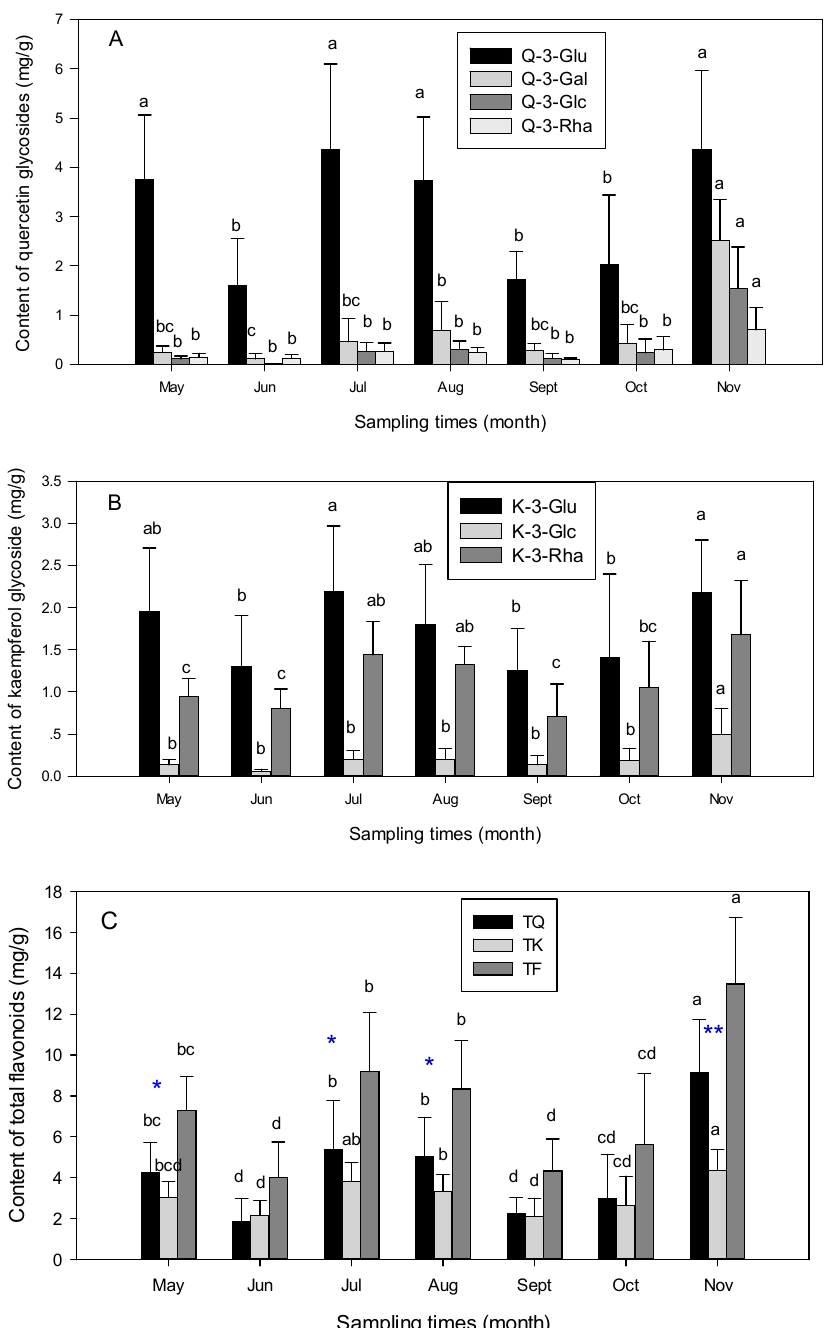
Figure 3. Seasonal variation of quercetin glycosides ( A ), kaempferol glycosides ( B ) and total flavonoids ( C ) in leaves of C. paliurus (mean ± SD). Q-3-Glu, Q-3-Gal, Q-3-Glc, Q-3-Rha, K-3-Glu, K-3-Glc, K-3-Rha, TK, TQ, and TF represent quercetin-3- O -glucuronide, quercetin-3- O -galactoside, quercetin-3- O -glucoside, quercetin-3- O -rhamnoside, kaempferol-3- O -glucuronide, kaempferol-3- O -glucoside, kaempferol-3- O -rhamnoside, total quercetin glycosides, total kaempferol glycosides, and total flavonoids, respectively. Different letters in this figure indicate significant differences between the sampling times for the same category according to Duncan’s test ( p < 0.05). Each value presented is the mean of 10 families. * and ** indicate variation between total content of quercetin glycosides and total content of kaempferol glycosides in the same month is significant at the 0.05 and 0.01 level, respectively.